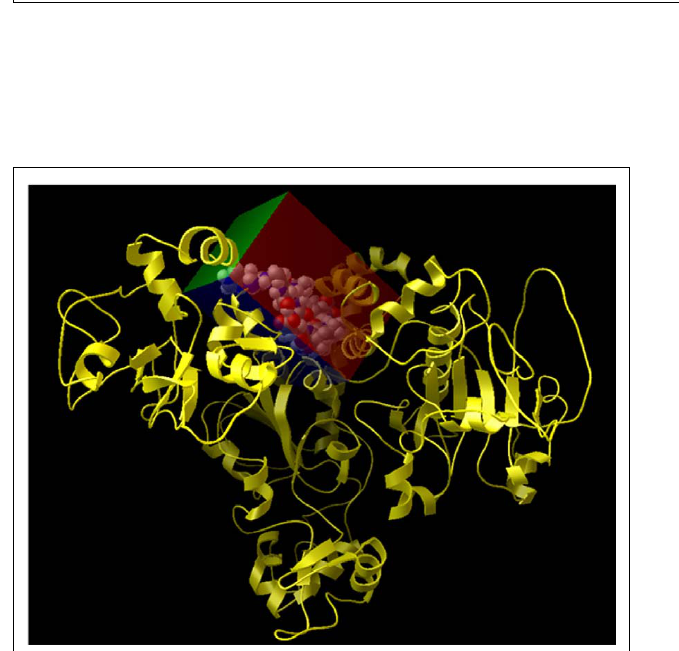
FIGUREA5 | Details of the grid parameters such as “number of spacing,”“number of grid points,” and “center grid box,” in all three directions.